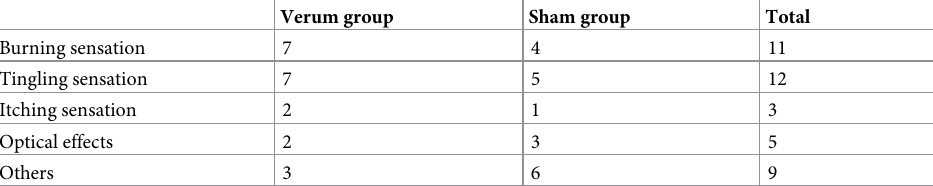
Table 2. Overview on side effects during